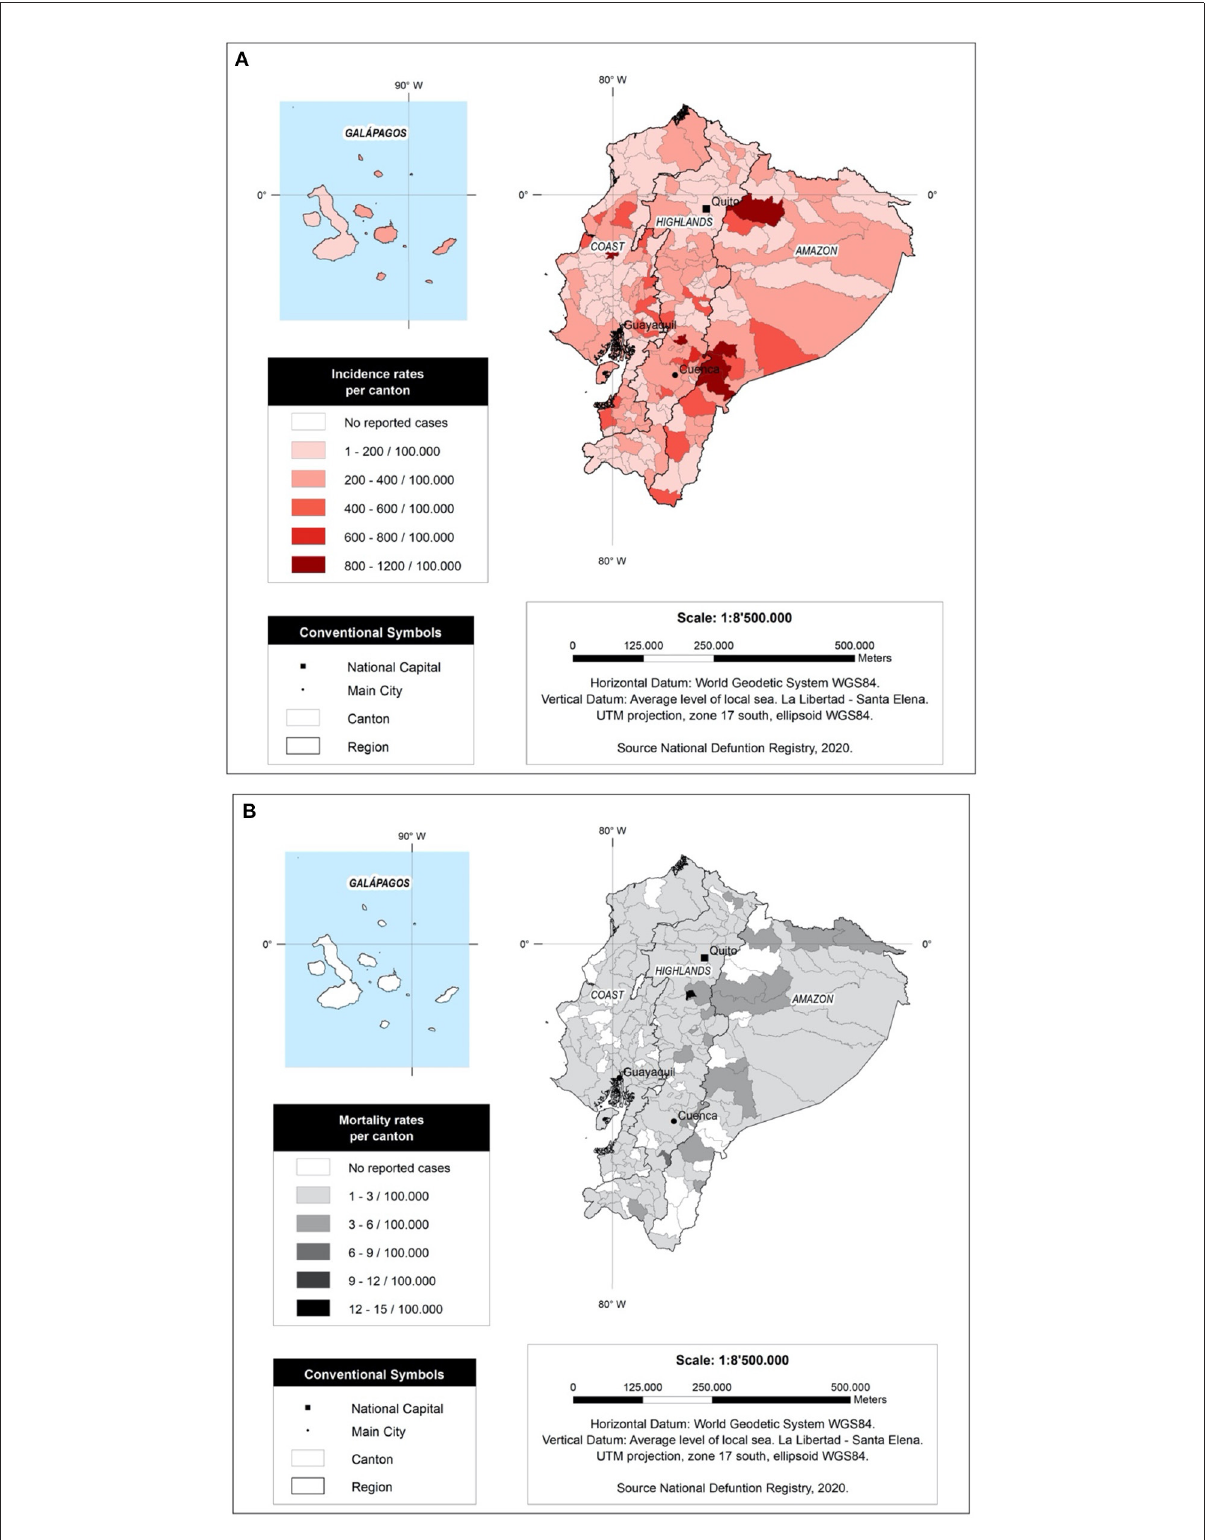
FIGURE4 Incidence and mortality rate per 100,000 per canton in Ecuador from 2011 to 2020. (A) WaSH related Incidence Rate per canton (B) WaSH related mortality rate per